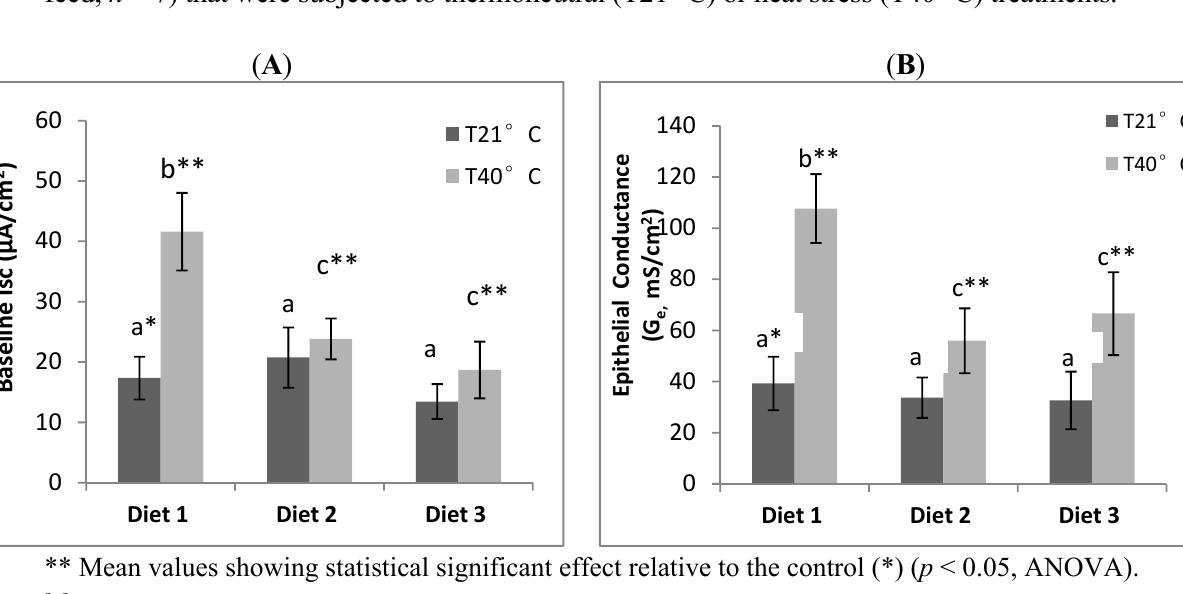
Figure 2. Effect of dietary Se supplementation on ileum ( A ) baseline short circuit current (Isc) and ( B ) epithelial conductance (G ) of non-heat stress and heat stress rats after 30 min of e mounting tissue in Ussing Chamber. Number shows mean value and standard error of ileum Isc or Ge for rats on control Diet 1 (0.12 µg Se/g feed; n = 7), Se-enriched Diet 2 (1 µg Se/g feed; n = 7) and Se-enriched + α -tocopherol Diet 3 (1 µg Se/g feed + 300 µg α -tocopherol/g